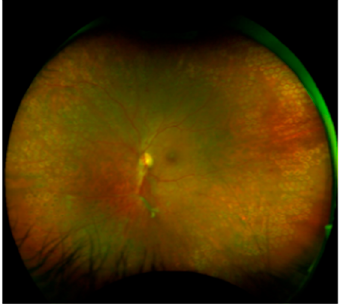
Figure 2. PDR and PRP with yellow laser (577 nm), a Pascal